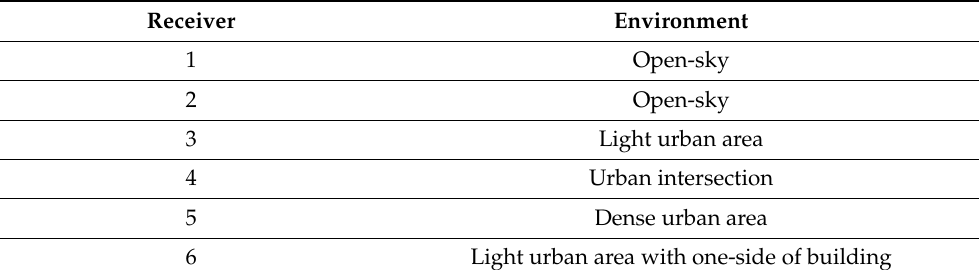
Figure 10. The receiver locations and the sky-plots during the multiagent static experiment. The sub-figures ( 1 )–( 6 ) are corresponding to the sky-plots with buildings and satellites for Agent 1–6. Table 2. Surrounding environment of each receiver during the multiagent experiment.